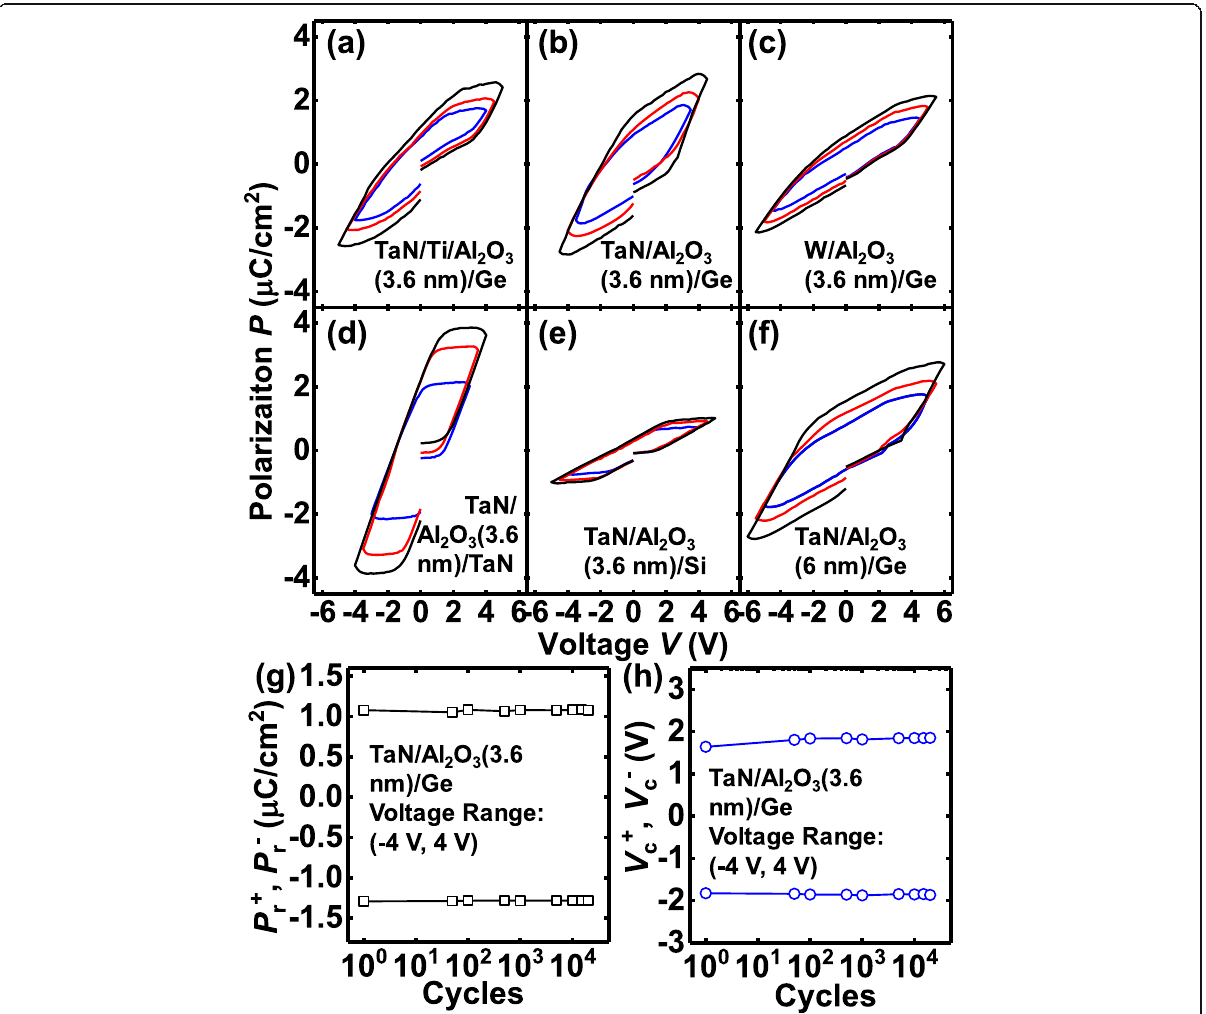
Fig. 2 Measured P vs. V characteristics of the Al 2 O 3 capacitors with different electrodes. a , b , and c showing the P - V curves of TaN/Ti/Al 2 O 3 /Ge, TaN/Al 2 O 3 /Ge, and W/Al 2 O 3 /Ge, respectively, with a 3.6-nm t AlO . d and e showing that the P sat is enhanced(reduced) by using TaN(Si) as the bottom electrode instead of Ge. f